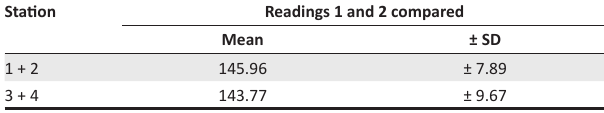
TABLE 6: Summary statistics by experienced and novice